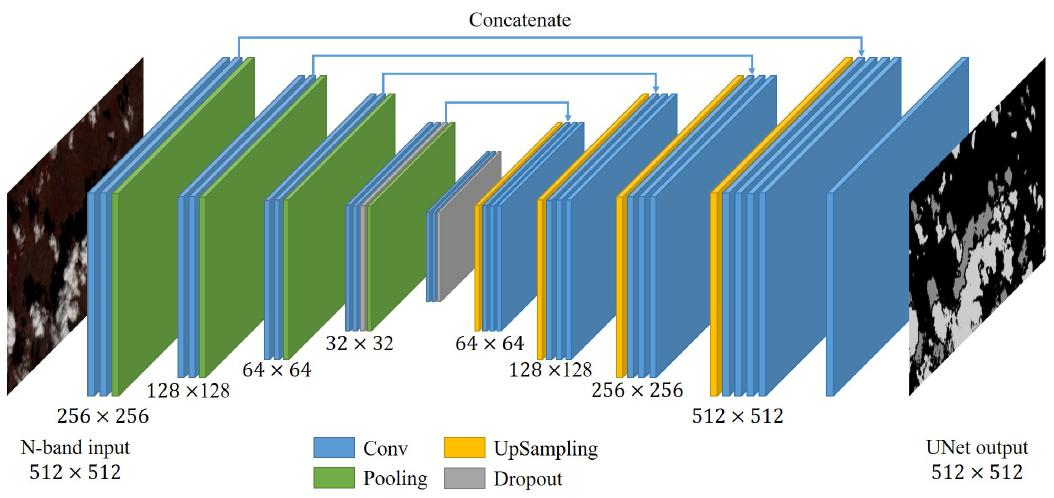
Figure 3. UNet structure for localizing the clouds and shadows